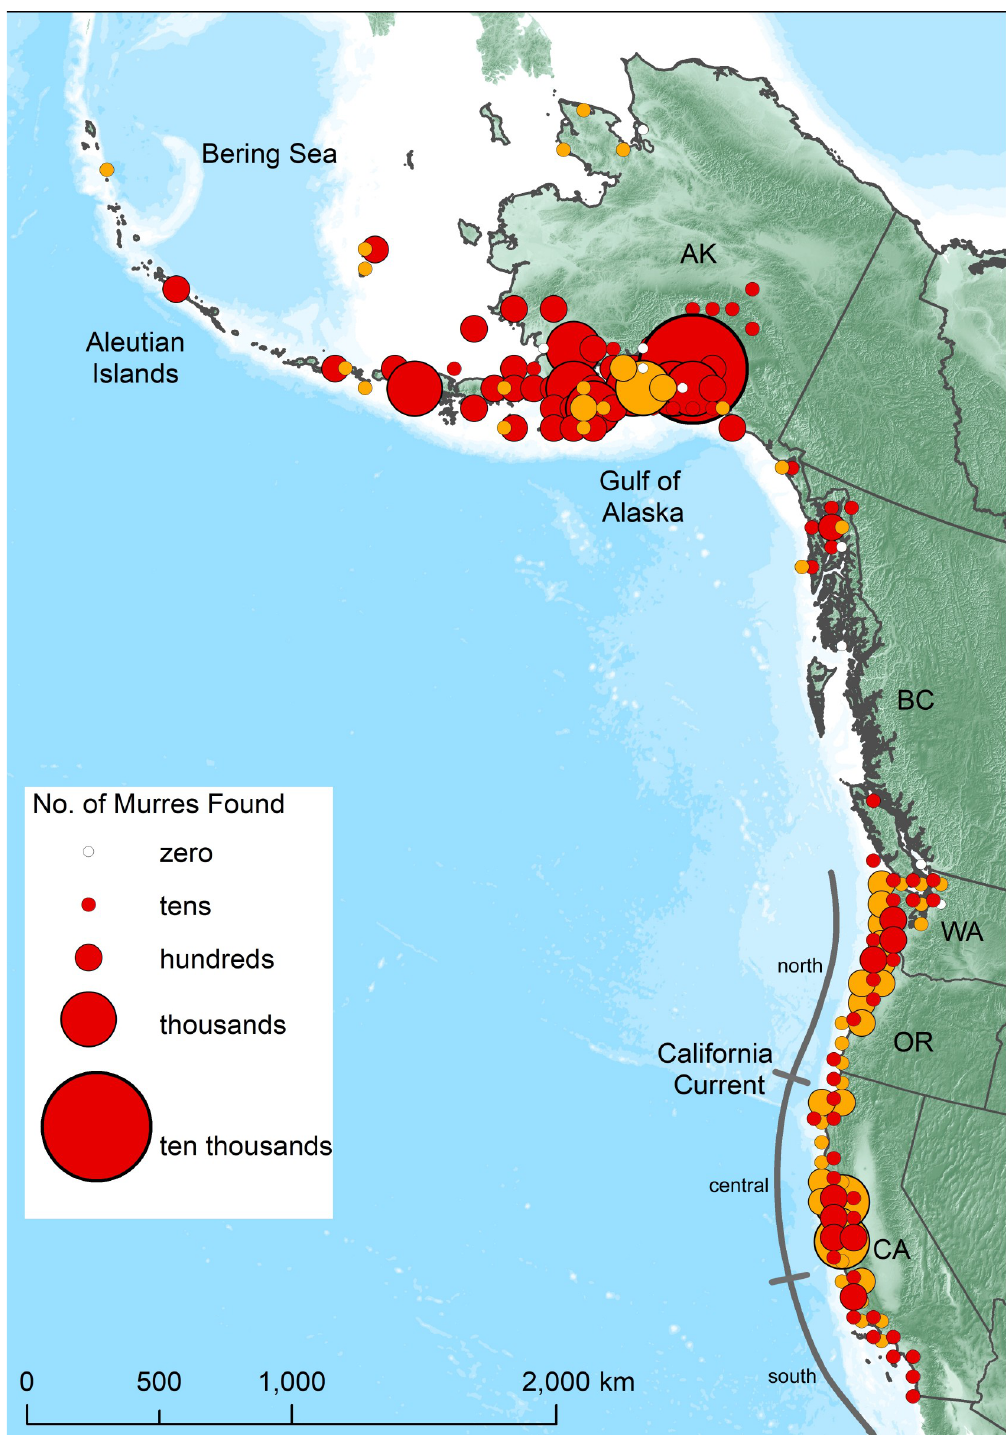
Fig 2. Numbers of dead or moribund common murres observed on beaches that were surveyed systematically (gold circles; ~monthly) and with opportunistic beach surveys and rehab captures (red circles). Areas in which zero dead murres were encountered during surveys are indicated by white circles. All remaining coastlines (without any circles) were not surveyed. Note the California Current System is divided roughly into 3 sections: north (nCCS), central (cCCs) and south (sCCS).